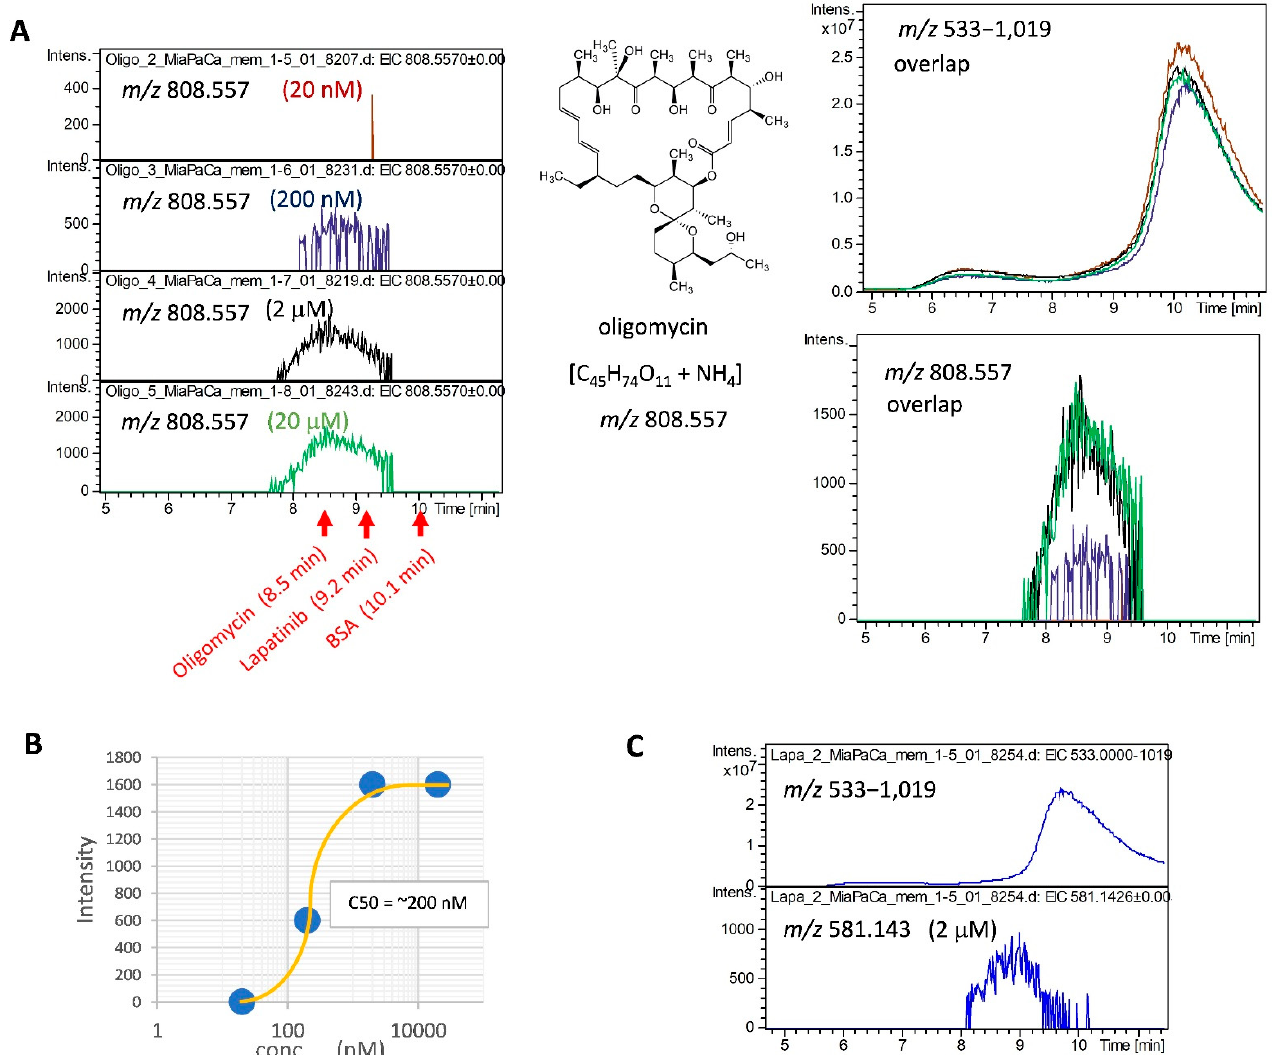
Figure 2. Detection of interaction between the membrane protein fractions from MiaPaCa2 cells and the membrane protein-specific inhibitors. ( A ) Concentration dependence of the ATP synthase inhibitor- interaction. In total, 20 nM to 20 µ M of oligomycin was added to the membrane protein fraction from MiaPaCa2; then, the interaction between lapatinib and membrane proteins was analyzed. The elution profiles of oligomycin binding to its specific target protein were monitored using detection at m / z 808.557. ( B ) Interaction curve between oligomycin and the MiaPaCa2-derived membrane proteins by SEC-MS. The curve showed that the 50% interaction concentration was approximately 200 nM using the SEC-MS method. ( C ) Detection of interaction between lapatinib and the MiaPaCa2-derived membrane proteins by SEC-MS. In total, 2 µ M of lapatinib was added to the membrane protein fraction from MiaPaCa2, and the interaction between lapatinib and membrane proteins was analyzed.